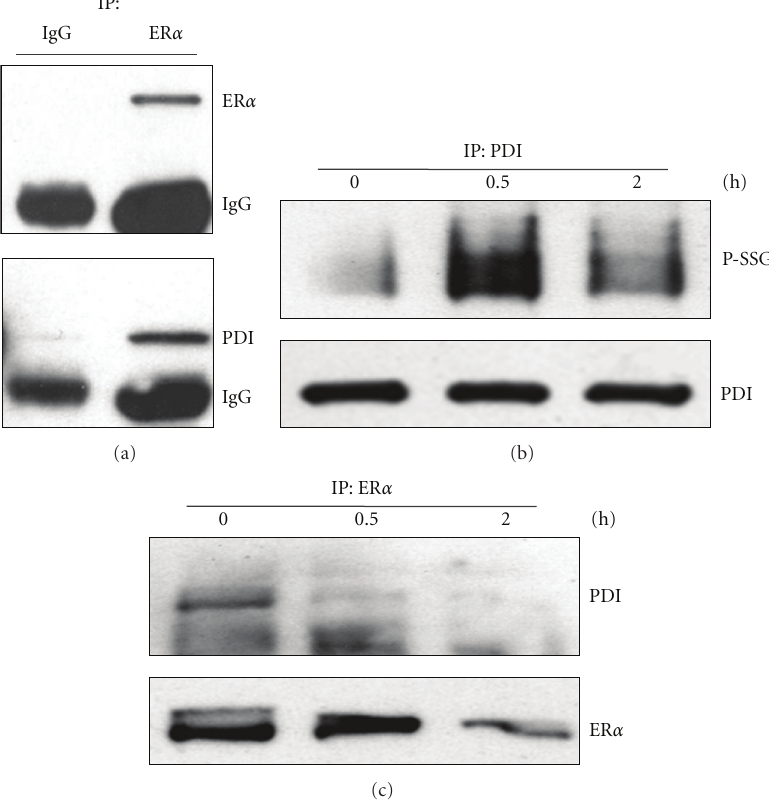
Figure 3: PABA/NO abrogates PDI-ER α interaction. (a) MCF7 cell lysates (1mg) were incubated with anti-ER α antibody or control IgG at 4 ◦ C overnight. (b) MCF7 cells were treated with DMSO or 20 μ M PABA/NO for the indicated times. Cell lysates (300 μ g) were incubated with anti-PDI antibody at room temperature for 4h. The precipitated endogenous PDI was subjected to Western blot with anti- S -glutathionylation (P-SSG) and anti-PDI antibodies. (c) MCF7 cells were treated with DMSO or 20 μ M PABA/NO for the indicated times. Endogenous ER α was precipitated with the anti-ER α antibody at 4 ◦ C overnight. The precipitates were subjected to Western blot with anti- ER α and anti-PDI